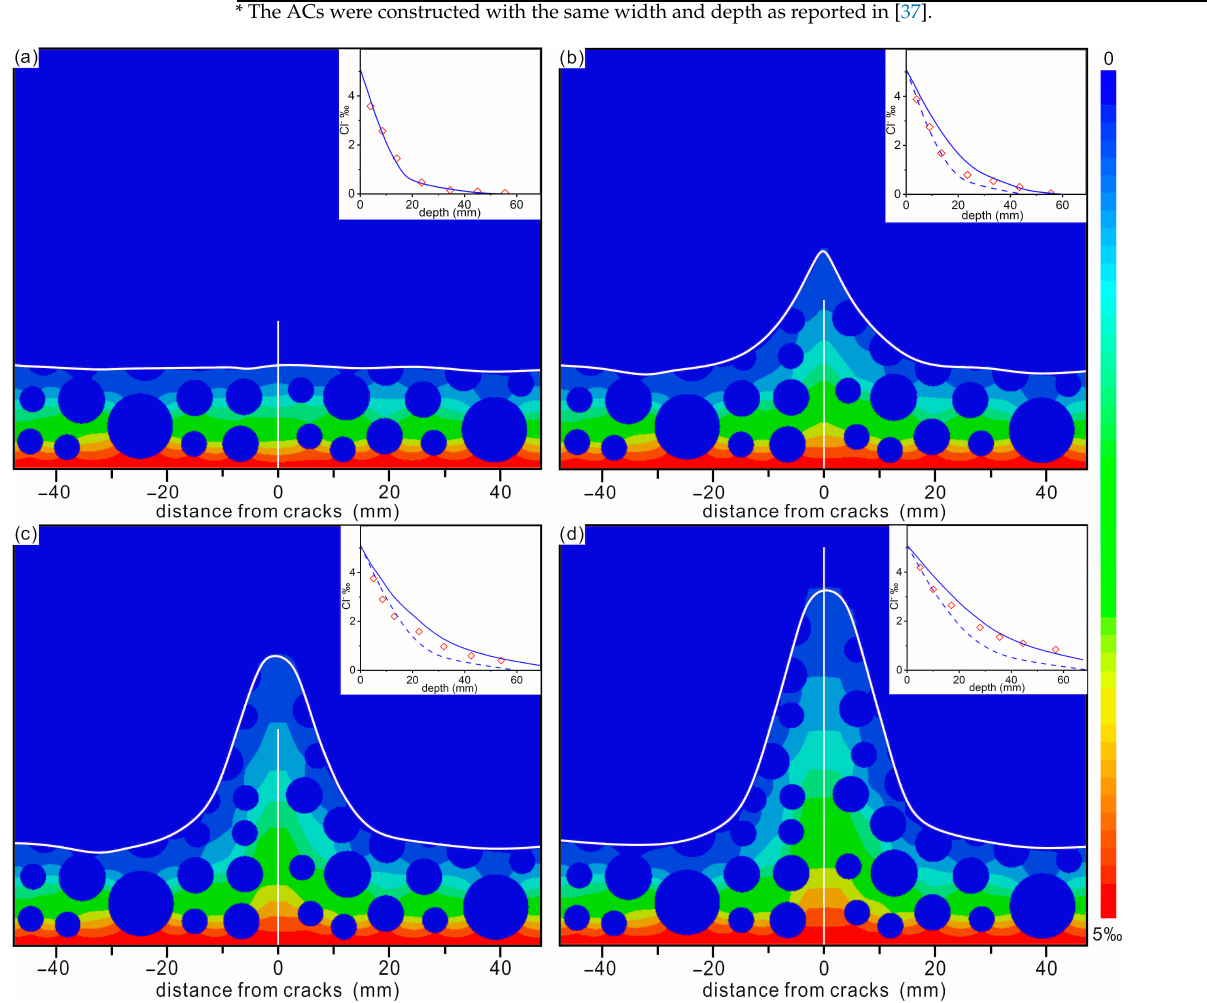
Figure 5. Di ff usion cloud maps of chloride ions in concrete containing ACs with widths of ( a ) 49.0 µm, ( b ) 102.9 µm, ( c ) 210.7 µm and ( d ) 392 µm. The outermost di ff usion contours are highlighted with white lines. The chloride ion concentrations along the direction highlighted by white arrows are shown as insets. The experimental data of [37] (reproduced with permission from [37], copyright 2007 Elsevier) and simulation results without DZs are also shown as diamonds and dashed lines in the insets for comparison. Colors from blue to red represent chloride ion concentrations from 0 to 5‰. Table 1. The width and depth of ACs, DZs and the di ff usion coe ffi cient ( D AC ) of chloride ions in